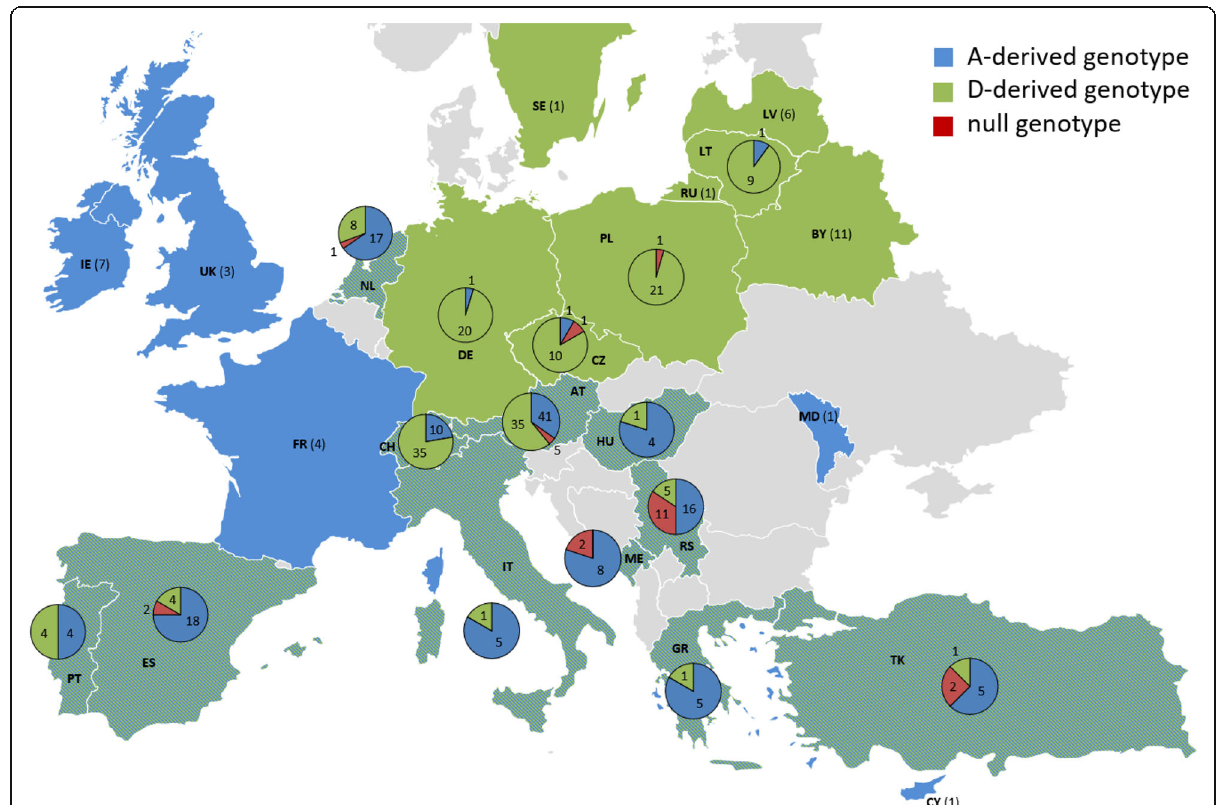
Fig. 3 Prevalence of archetypal genotypes A (blue) and D (green) in Europe and the Mediterranean Area in the timeframe 1958 – 2017. Pie charts denote the number of isolates of each genotype recovered in each country. If only one genotype was detected, the number of corresponding isolates is indicated between parentheses after the country code. Countries are colored according to the predominant archetypal genotype if this was retrieved in a fraction exceeding 80%, else they are shown in petrol blue. The null PCR genotype is indicated in